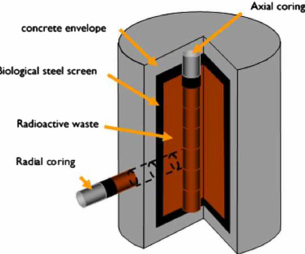
Fig. 11. Schematic diagram of core drilling.